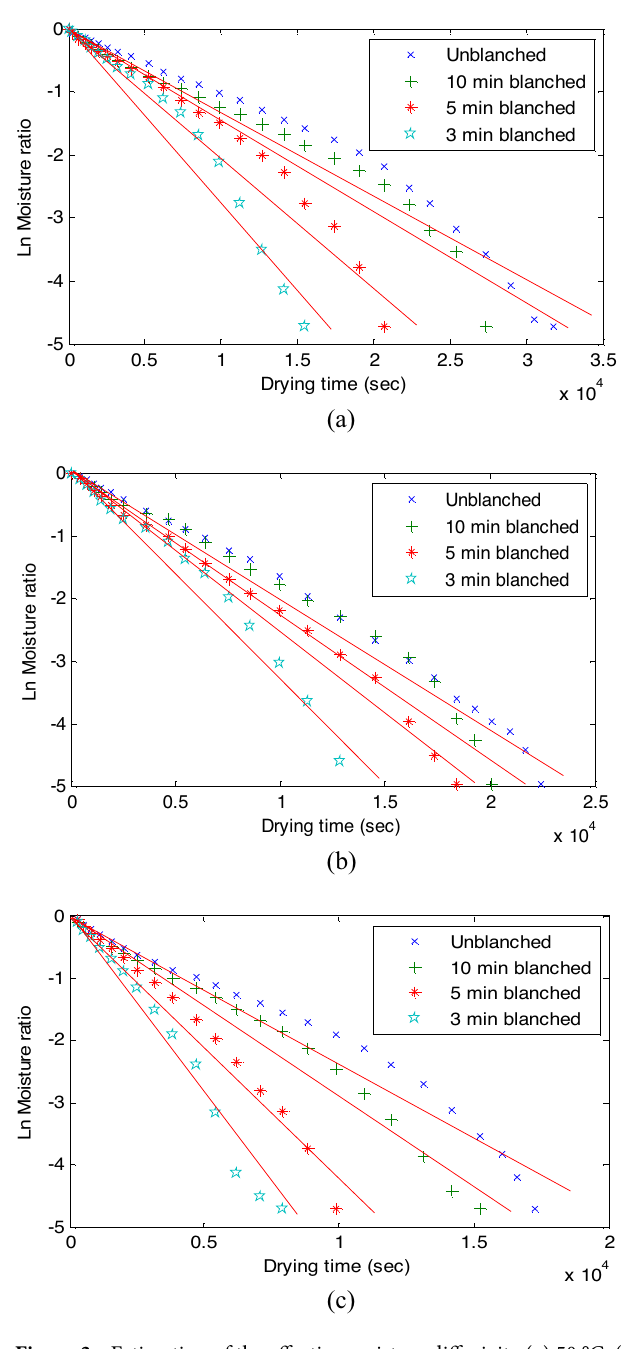
Figure 3. Estimation of the effective moisture diffusivity ( a ) 50 °C, ( b ) 60 °C and ( c ) 70